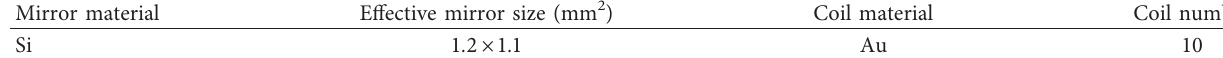
Table 1: Main properties of electromagnetic